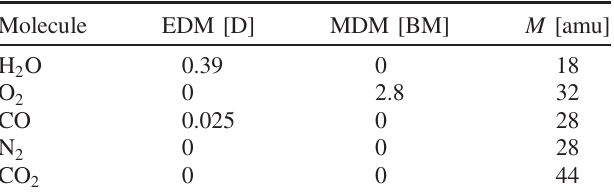
TABLE I. Permanent electric (EDM) and magnetic dipole moments (MDM) of various air molecules in units of Debye (D) and Bohr magneton (BM), respectively, along with the molecule mass M in atomic mass units